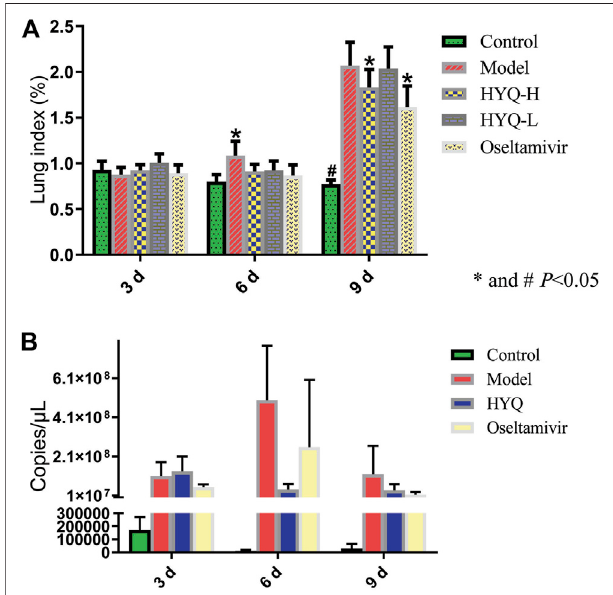
FIGURE 2 | Ef fi cacy evaluation of HYQ against viral pneumonia in mice infected with in fl uenza A virus (H1N1) (A) Lung index. HYQ-H: high-dosage HYQ. HYQ-L: low-dosage HYQ (B) Viral load results of the mouse lung. HYQ: high-dosage HYQ. 3, 6 and 9 days: virus infection time.